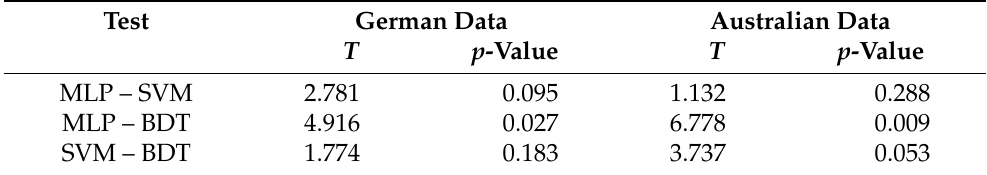
Table 2. Statistical test for comparing the area under the ROC curves estimated by the different models.